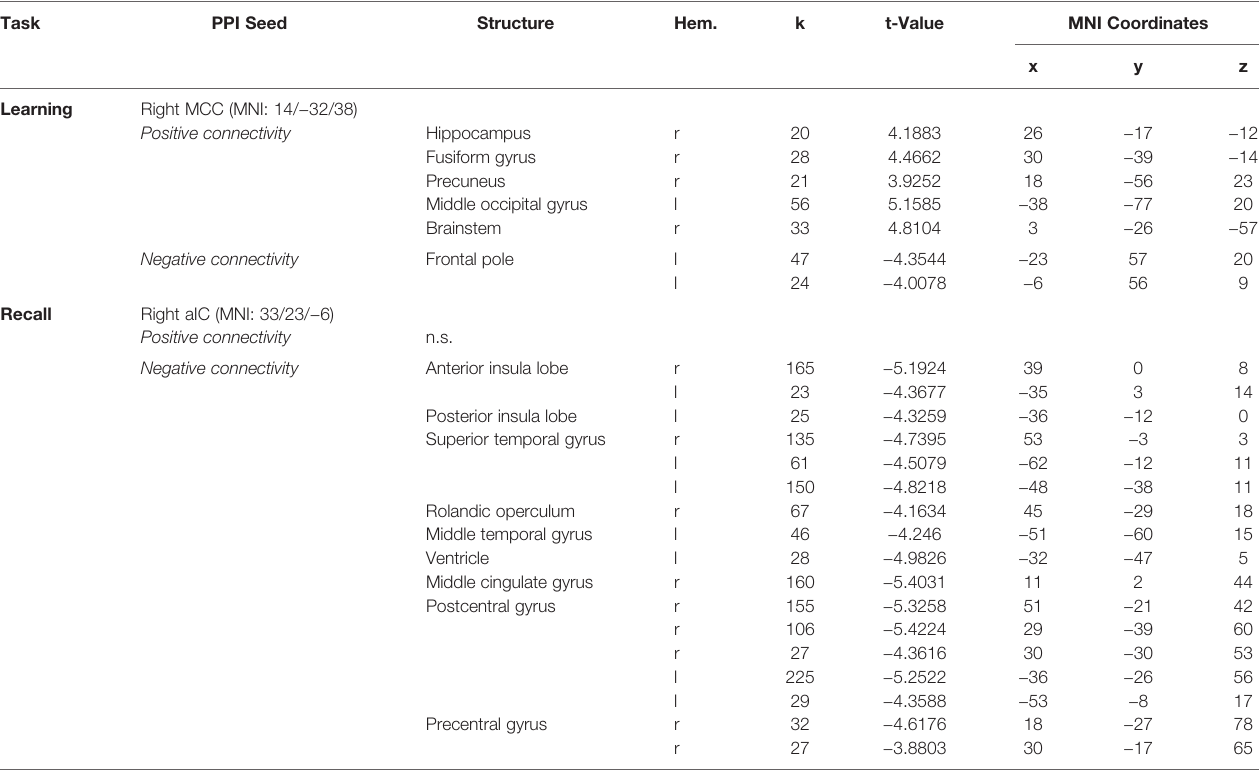
Seed regions of the gPPIs were derived from the conjunction analyses ’ fi ndings. The reported values are thresholded at p < 0.001 uncorrected and with a minimum cluster size of 20 contiguousvoxels.TheloweredstatisticalthresholdwasappliedbecausePPIanalysesingeneralcanbeassumedtohavearelativelyhighchanceoffalsenegativescomparedtostandard activation analyses (38, 39). MCC, middle cingulate cortex; aIC, anterior insular cortex. Coordinates are in MNI space. Hem., emisphere; l, left; r, right; coordinates are in MNI space; k, cluster size; n.s = not signi fi